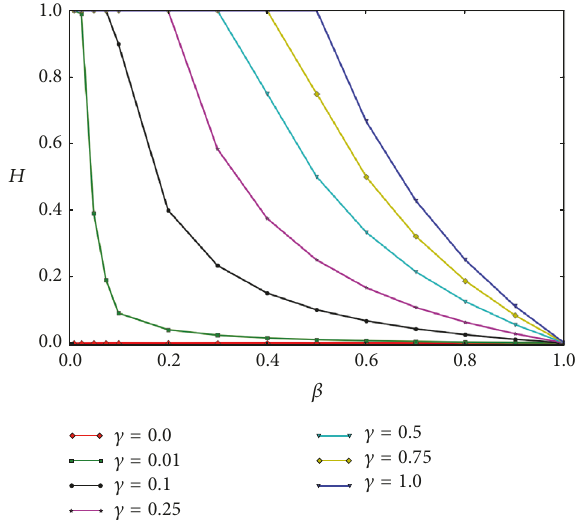
Figure 2: Absolute value of the system Hamiltonian in function of the 𝛽 parameter adopted for realizing a diluted ferromagnet. The legend indicates the related value of 𝛾 for each curve. Results have been averaged over different simulation